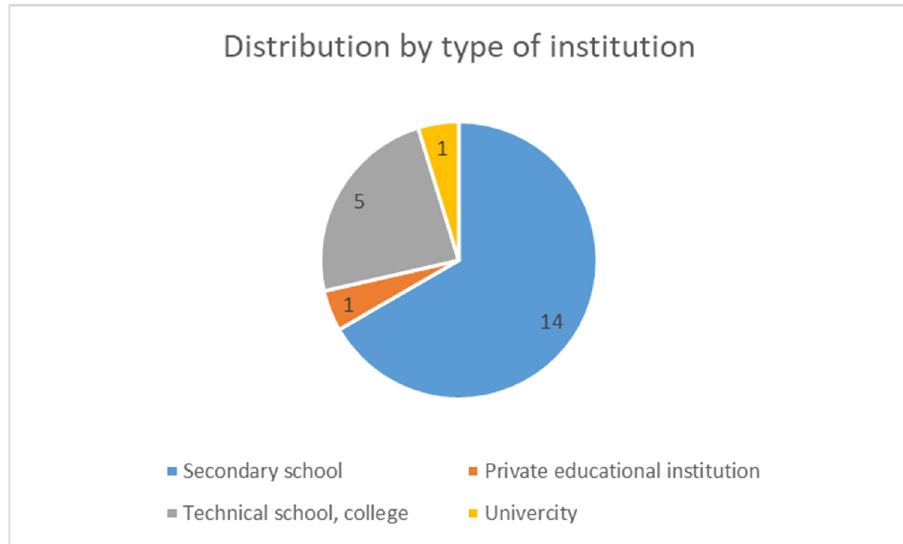
Figure 1. Distributions by type of institution (N = 21 cases).